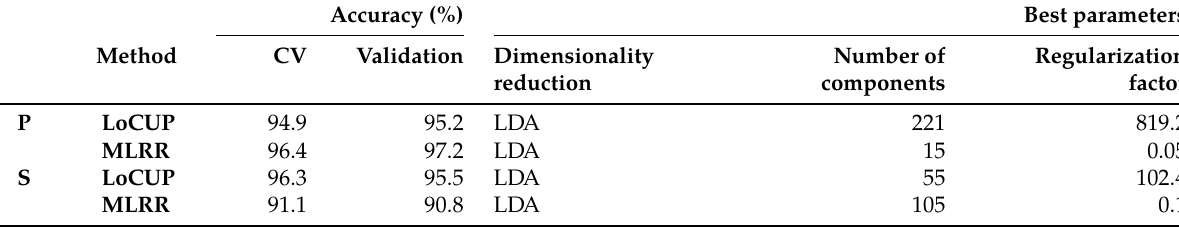
Table 1: Results for the primary (P) and simulated (S) experiments for both methods. Accuracy (%) Best parameters Method CV Validation Dimensionality Number of reduction